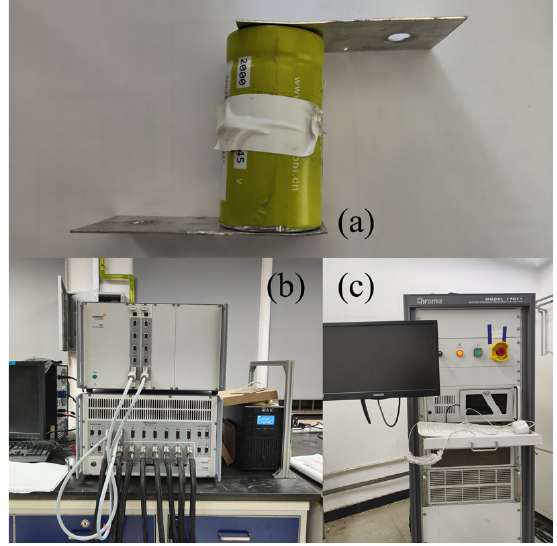
Figure 1. Materials and experimental equipment. ( a ) One of the LTO cells used in this study; ( b